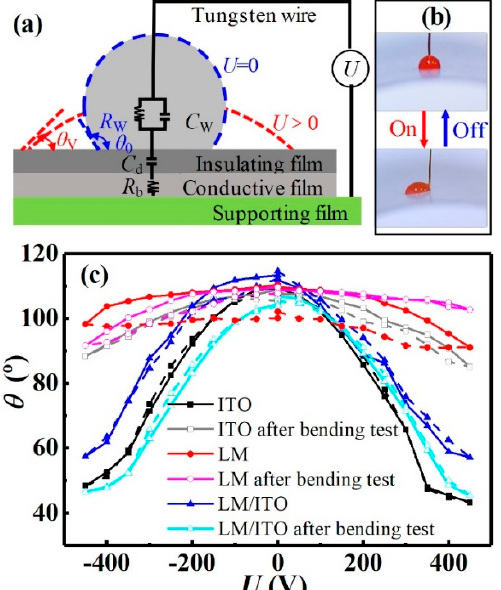
Figure 5. ( a ) Schematic of the electrowetting on dielectric (EWOD) device. The equivalent circuit diagram consists of a water droplet, a dielectric layer, and a conductive layer. ( b ) Optical images of a 2.0 µ L water droplet on the top of a curved film, showing θ at U = 0 and 450 V. ( c ) EW performance of sessile drops on the liquid-infused-membranes (LIMs) with single-ITO, single-LM ( λ = 3.11 µ m), and composite LM/ITO ( λ = 1.10 µ m) films as the conductive layers.